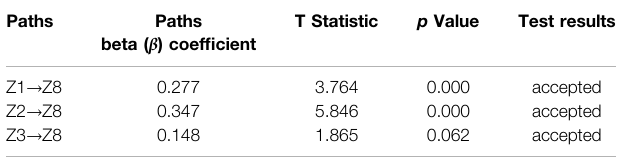
TABLE 8 | Path coef fi cient excluding mediating variables and signi fi cance test result. p Value Test results Paths Paths beta ( β ) coef fi